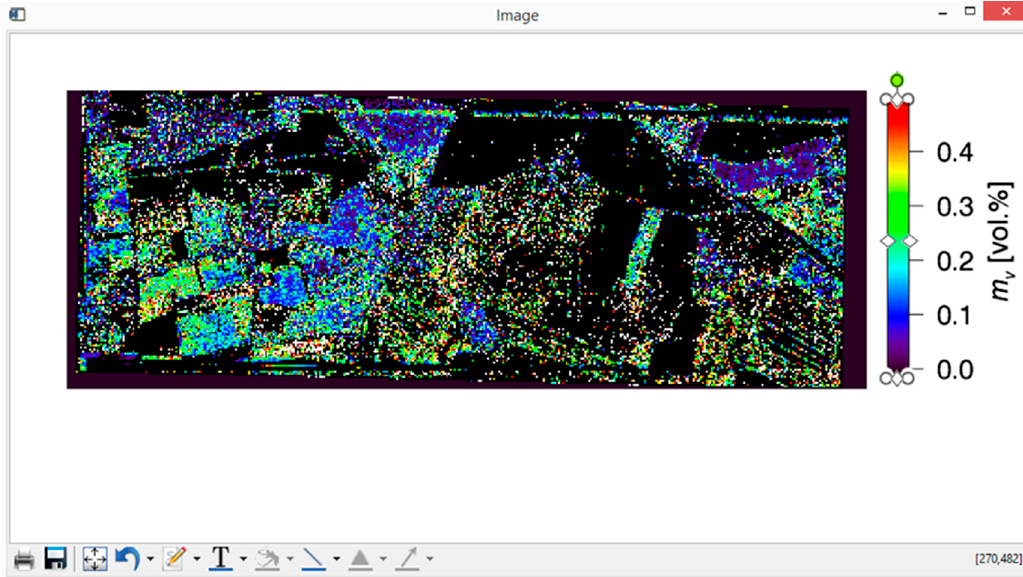
Figure 12. PTSM-OOP’s retrieval of volumetric soil moisture m V for the Demmin area (16 May 2006). North is the top of the image, east is on the right.